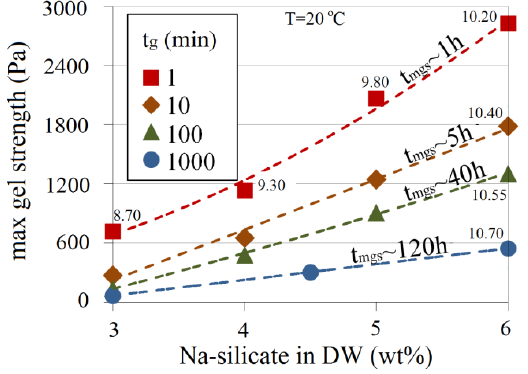
Figure 18. Maximum gel strength as a function of Na-silicate content and t Corresponding t values are shown for different gelation times. pH values are presented mgs in the graph for 6 wt% Na-silicate content with different gelation times and for the = 1 min. different Na-silicate contents with t g